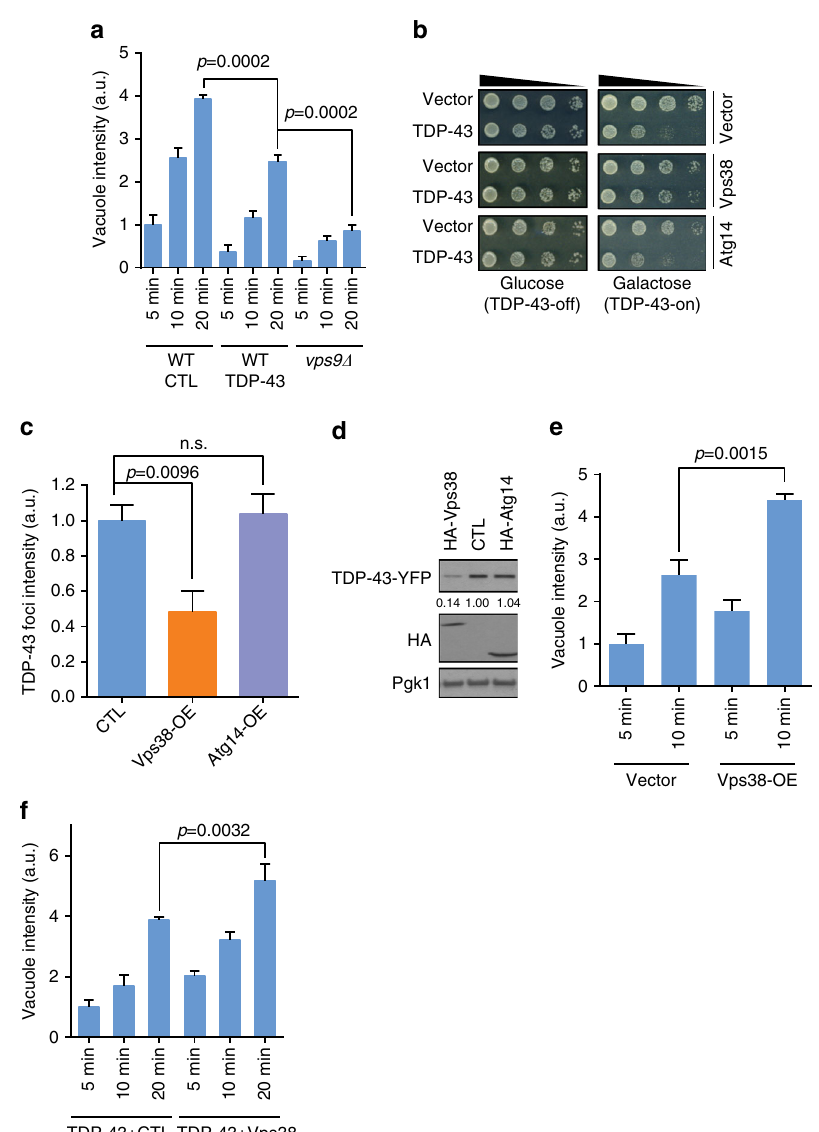
Fig. 3 TDP-43-induced toxicity and endocytosis defects are rescued by Vps38 overexpression in yeast. a WT cells transformed with vector or TDP-43-YFP, and vps9 Δ cells were stained with FM4-64 dye (8 µ M) for indicated time and examined. Vacuolar membrane staining intensity was analyzed. Signi fi cance was assessed by one-way ANOVA. b WT co-transformed with TDP-43-YFP and either multi-copy empty vector, Vps38, or Atg14-expressing plasmids. c , d Same strains were quanti fi ed for TDP-43-YFP foci intensity (Supplementary Fig. 3) ( c ) and protein levels ( d ), which were assessed relative to Pgk1 loading control. Signi fi cance in c assessed via one-way ANOVA. n.s. = no signi fi cance. Repeated data are shown as mean ± s.e.m. e , f WT cells transformed with indicated plasmids were examined as in a . Signi fi cance was assessed by two tailed Student ’ s t test. Data are shown as mean ±